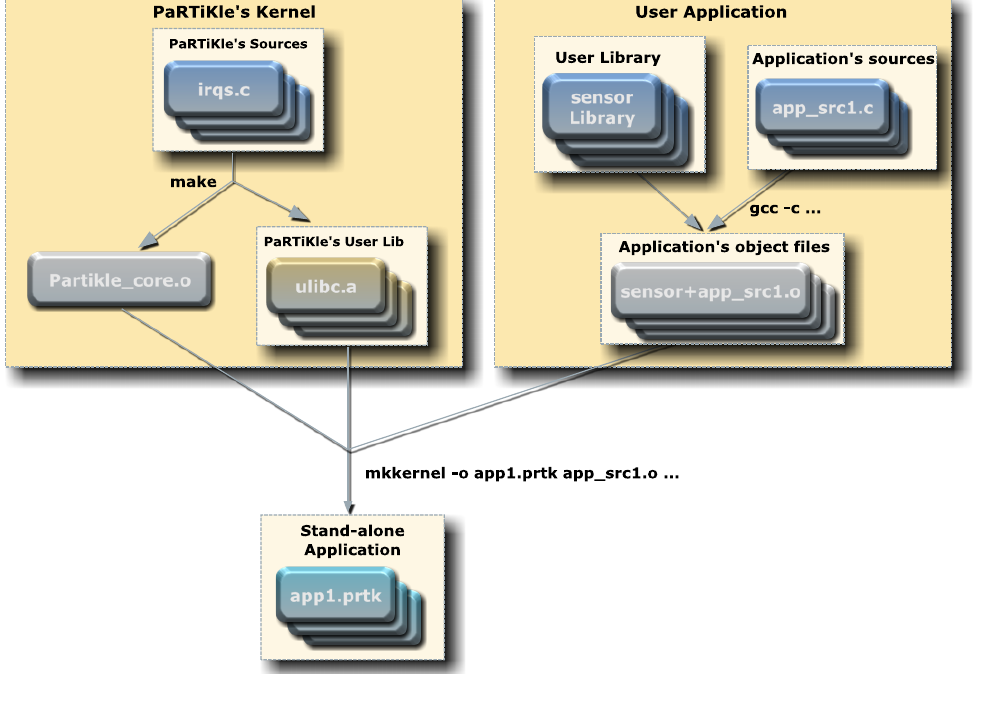
Figure 5. Building Process of Sensor